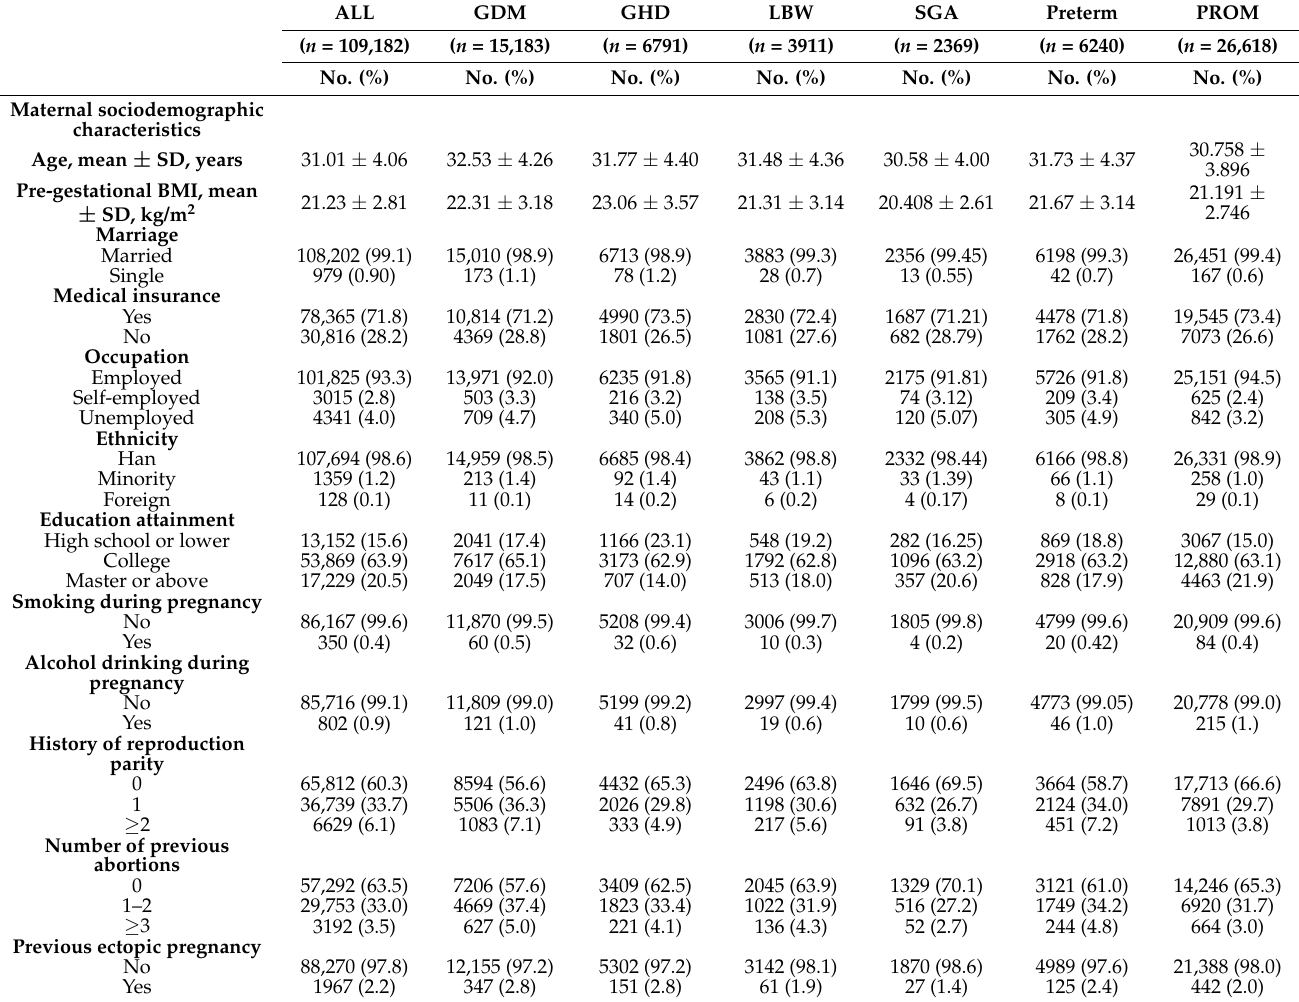
Table 1. Maternal characteristics of all pregnant